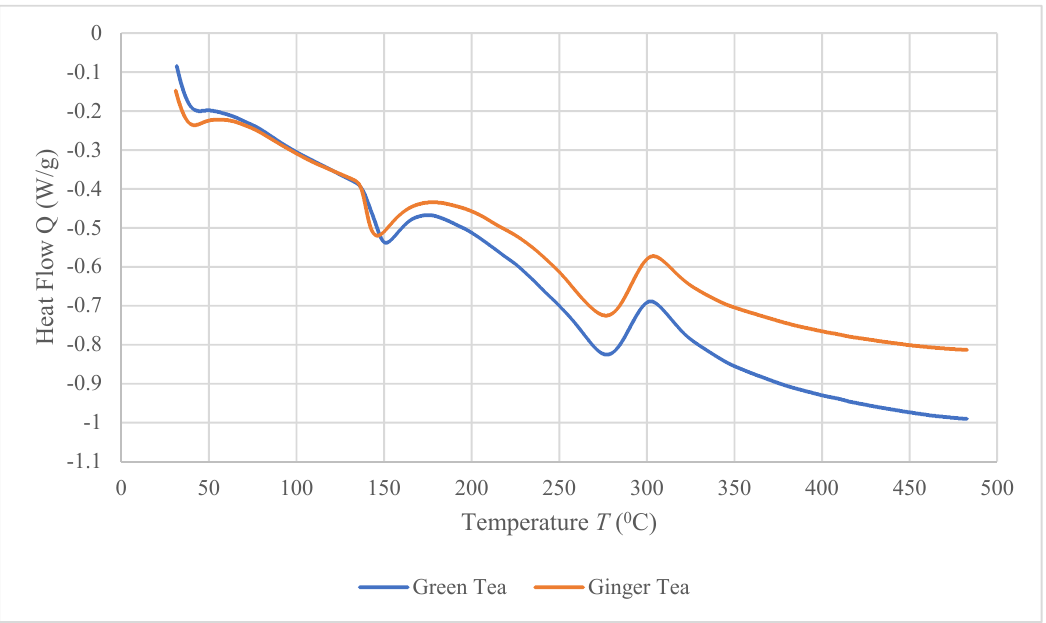
Figure 7. DSC analysis curves of the developed bioplastics samples. Table 4. TGA test results of bioplastics samples.